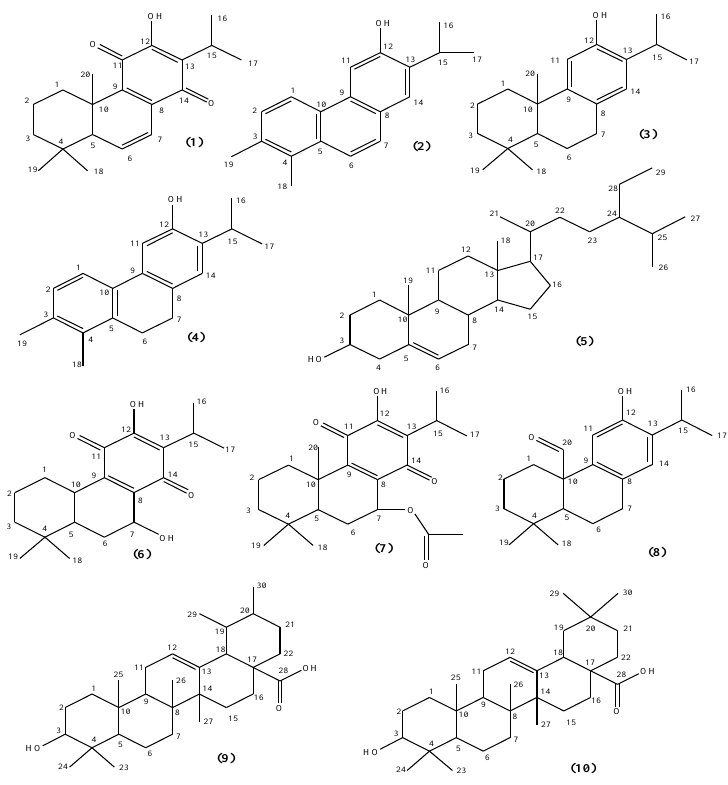
Figure 1. Chemical formulae of the isolated compounds: 6,7-dehydroyleanone ( 1 ), 12-demethylmulticaulin ( 2 ), ferruginol ( 3 ), 12-hydroxy abieta-1, 3, 5( 10 ), 8, 11, 13-hexaene ( 4 ), β -sitosterol ( e5 ), horminone ( 6 ), 7-acetoxyhorminone ( 7 ), pisiferal ( 8 ), ursolic acid ( 9 ), and oleanolic acid ( 10 ).